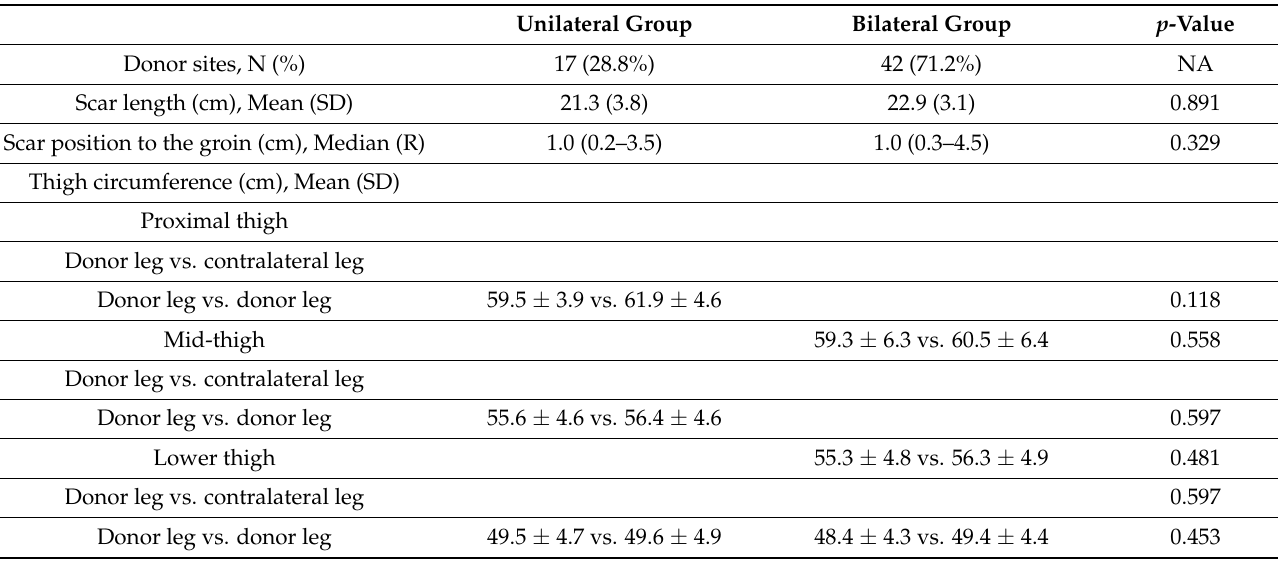
Table 4. Aesthetic outcome.